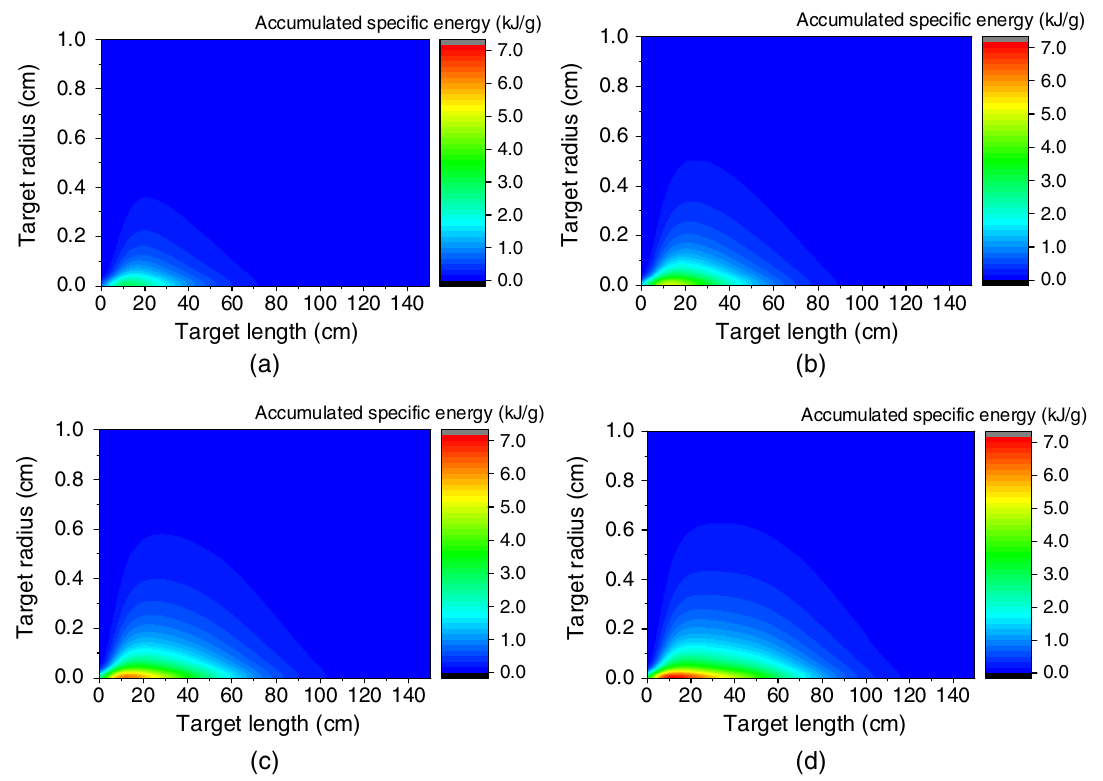
FIG. 4. Two-dimensional distributions of accumulated specific energy in units of kJ = g in the r - z plane derived from FLUKA simulations (a) at t ¼ 1 . 8 μ s, after 36 bunches have been delivered, (b) at t ¼ 3 . 8 μ s, after 72 bunches, (c) at t ¼ 5 . 8 μ s, after 108 bunches, and (d) at t ¼ 7 . 8 μ s, after 144 bunches.